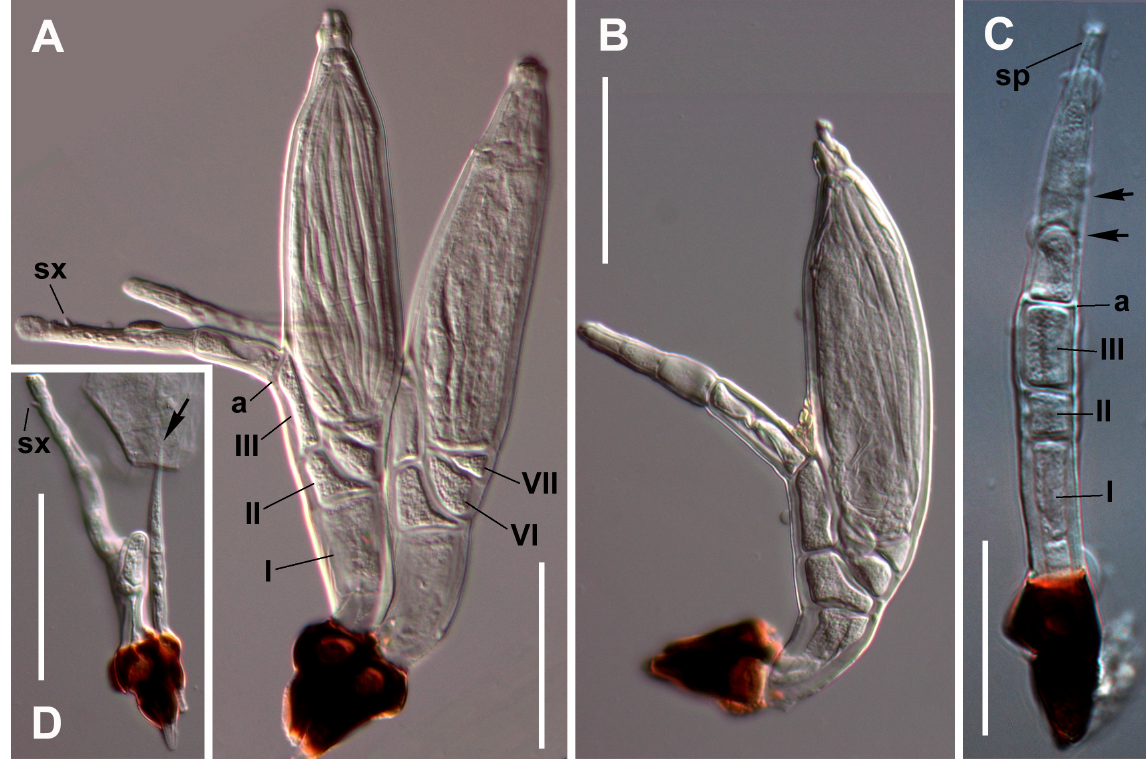
Fig. 4. Troglomyces dioicus Santam., Enghoff & Reboleira sp. nov. A – B . Mature female thalli with labelling of cells and other elements. C . Mature male thallus with labelling of cells and other elements. D . Paired immature thalli where original spore apex are labelled (sx for female at left; arrow for male at right). Scale bars: 50 µm (A–B, D), 25 µm (C). Photographs from: SS E617a (A), SS E617c (B, D) and C-F-92269